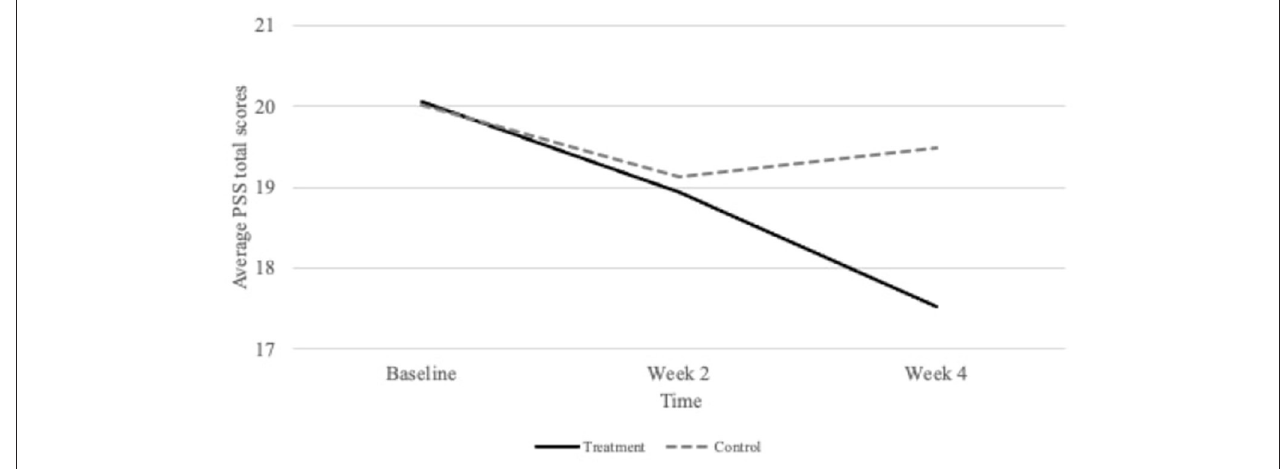
FIGURE 4 | Group specific changes in stress as measured by the Perceived Stress Scale (PSS) at baseline, 2 weeks, and 4